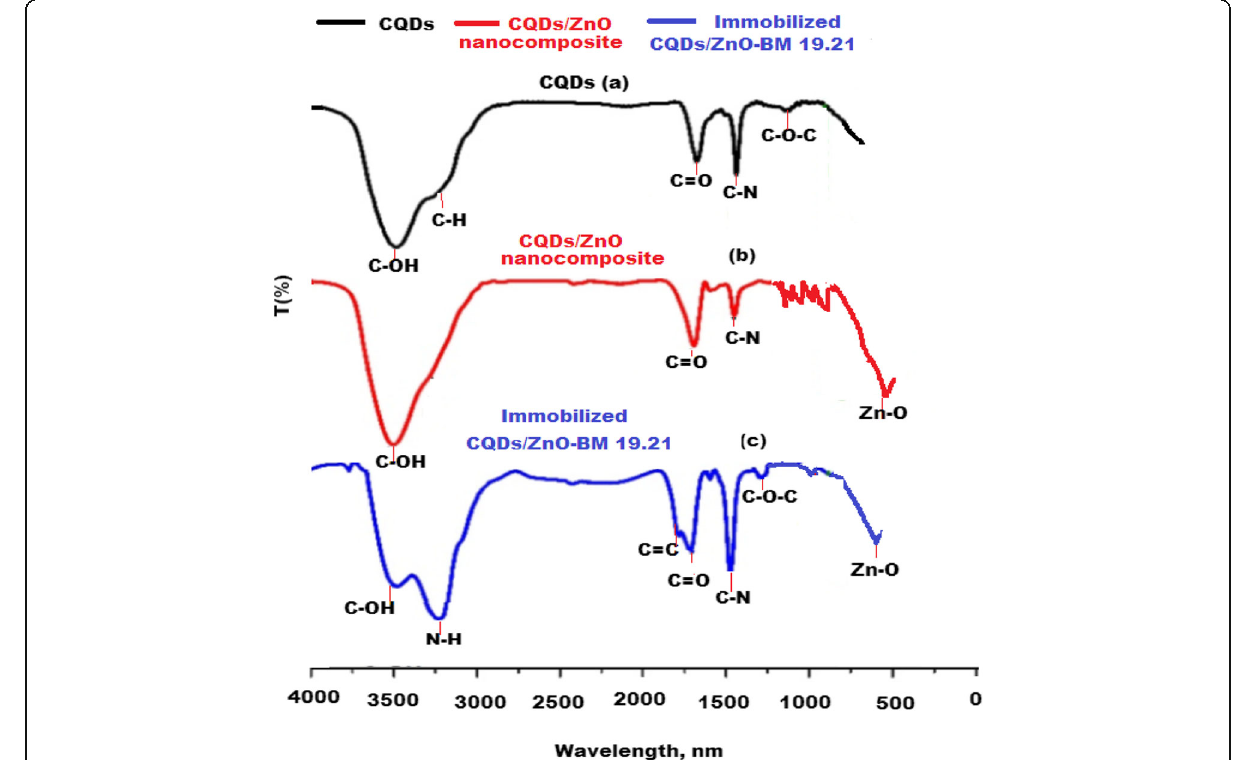
Fig. 5 FT-IR spectra of a CQDs, b CQDs/ZnO nanocomposite, and c immobilized CQDs/ZnO-BM 19.21